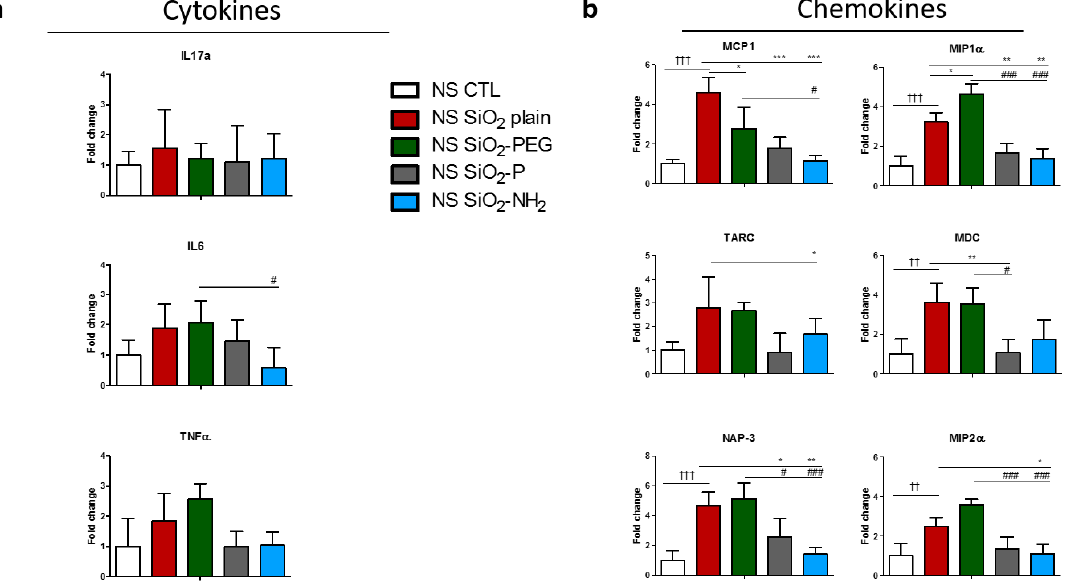
Figure 5. Surface modifications of silica nanoparticles diminish expression of certain inflammatory genes in non-sensitized mice (NS) mice in vivo . Representative gene regulations of ( a ) cytokines or ( b ) chemokines in mouse lungs 5 days after intratracheal instillation of 50 µ g SiO 2 plain (red), SiO 2 -PEG (green), SiO 2 -P (gray) or SiO 2 -NH 2 blue) or supernatant control (CTL) and ovalbumin challenge. Mean ± standard deviation were evaluated in lung by real-time PCR ( n = 4/group). One-way Anova † p < 0.05; †† p ≤ 0.01; ††† p ≤ 0.01 vs. CTL p ≤ 0.001; * p < 0.05; ** p ≤ 0.01; *** p ≤ 0.001 vs. SiO 2 plain. # p < 0.05; ## p ≤ 0.01; ### p ≤ 0.001 vs. SiO 2 -PEG ( n = 4). Part of the data, i.e., those relative to the cytokine TNF- α and to the chemokines MCP-1, MIP-1 α , TARC and MDC have already been shown in a different form in [21].